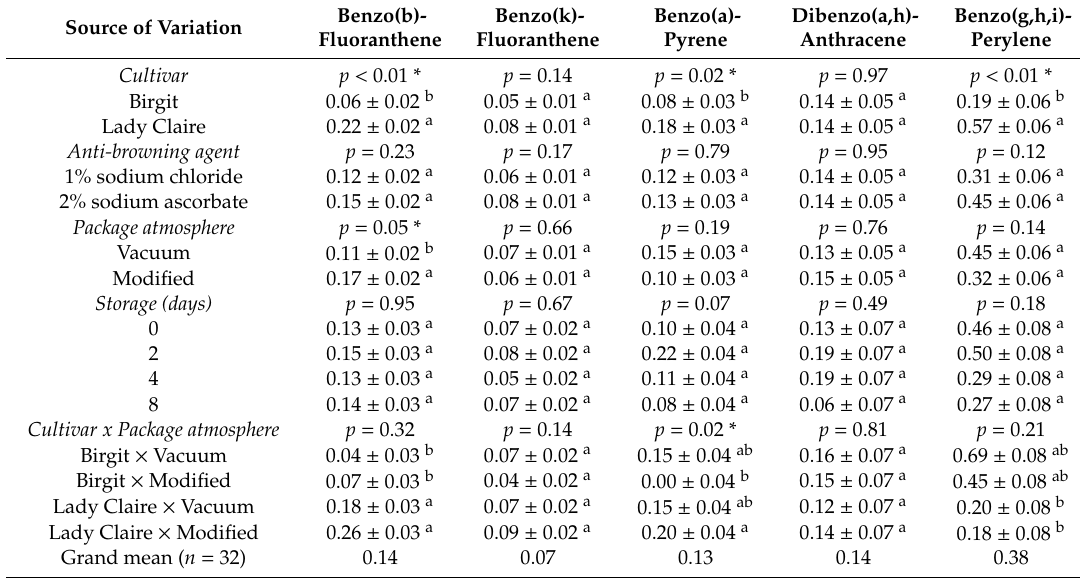
Table 4. Heavy (5 and 6 rings) PAH fraction ( µ g kg − 1 ) in fried fresh-cut potato as a ff ected by cultivar, anti-browning agent, packaging and storage